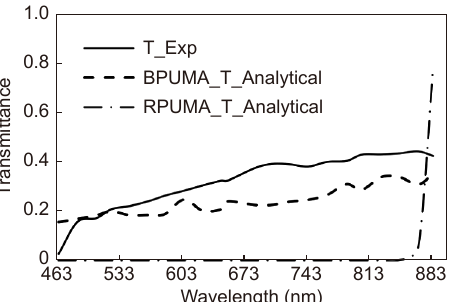
Fig. 10 | PUMA model evaluation with experimental transmit-